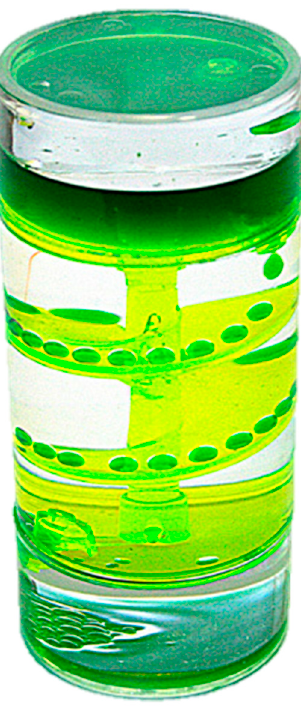
Figure 8. Anti-stress toy.